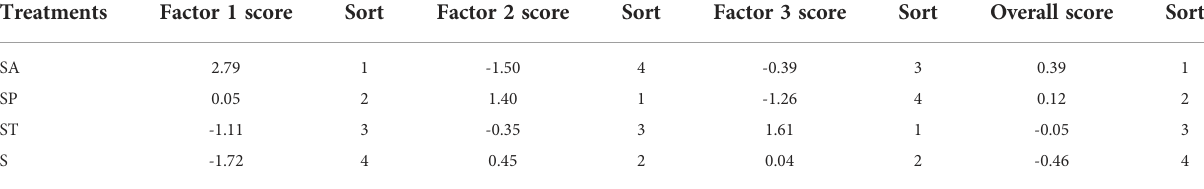
TABLE 6 Comprehensive evaluation scores of fruit quality.